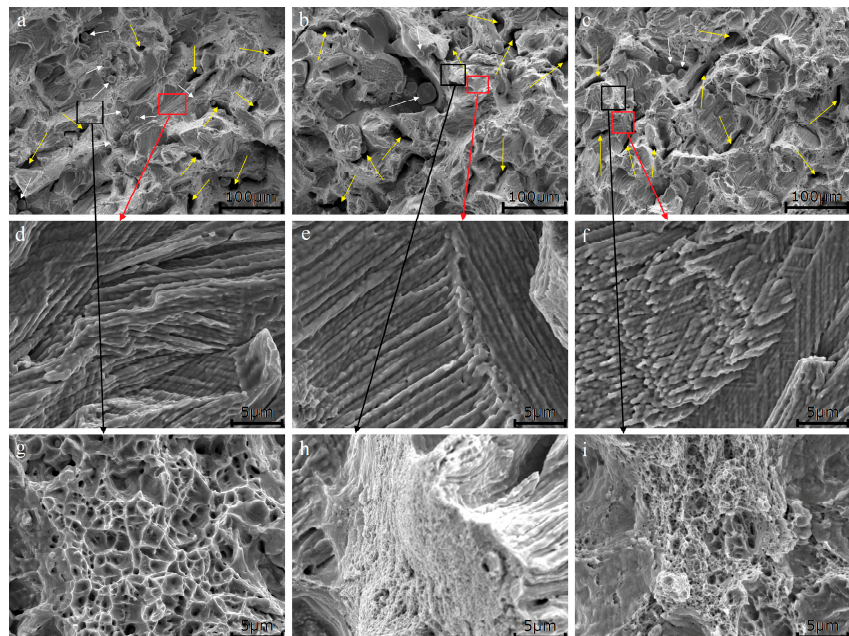
Figure 7. Fracture morphologies of the tensile test of three SLM SS316L samples at low magnifications ( a ) fine powder, ( b ) coarse powder, and ( c ) raw powder. High magnifications, cleavage plane ( d ) fine powder, ( e ) coarse powder, and ( f ) raw powder. High magnifications, dimple morphology ( g ) fine powder, ( h ) coarse powder, and ( i ) raw